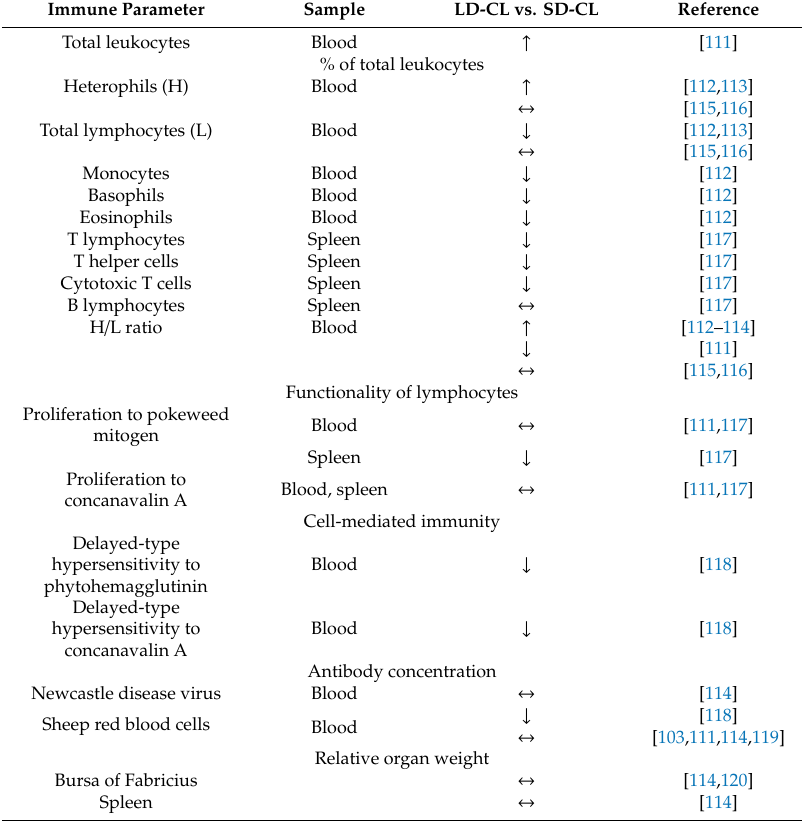
Table 2. Alterations of immune parameters of chickens provided with constant light under long-day conditions (LD-CL) compared to short-day conditions